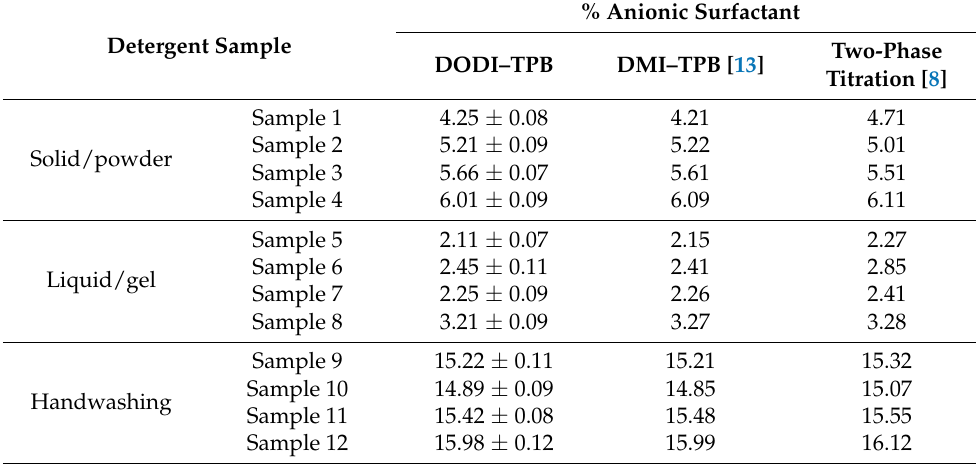
Table 5. Potentiometric titration results of detergent commercial products with the DODI–TPB surfactant sensor as an endpoint indicator and CPC as a titrant, compared with the ISE surfactant sensor and a referent two-phase titration